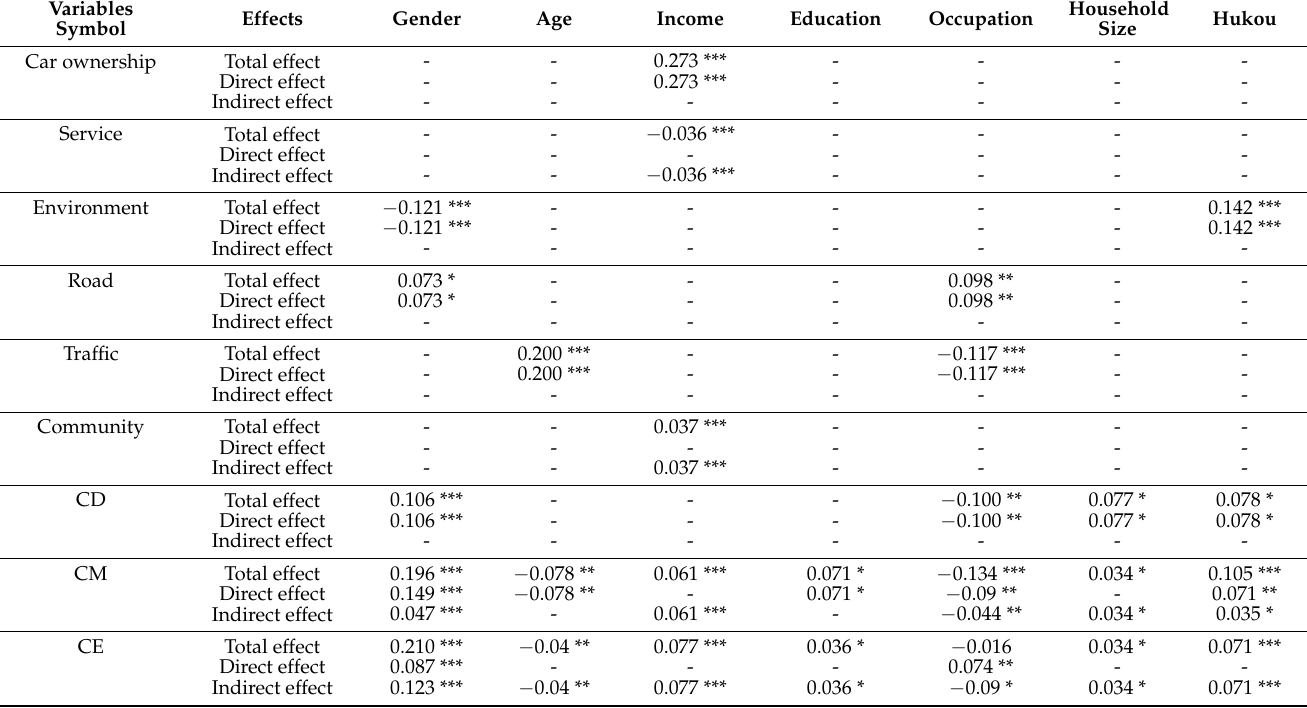
Table 11. Standardized direct, indirect and total effects of socio-demographic variables on endoge- nous